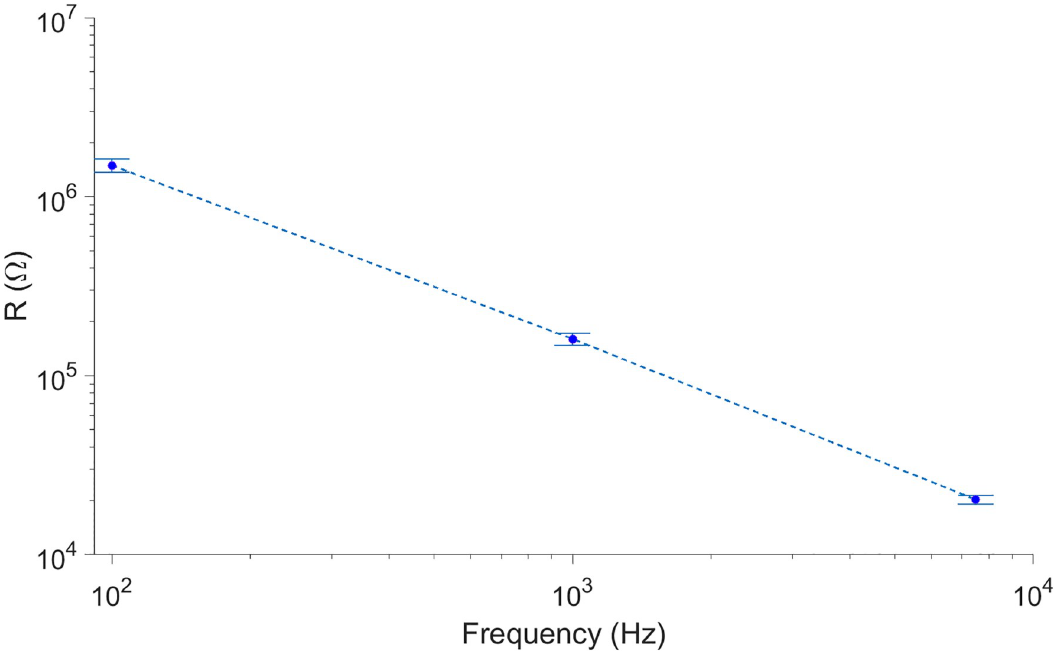
Fig 2. Impedance of gold electrodes from commercial MEA chips. The impedances were measured with the setup at fixed frequencies of 100, 1000 and 7500 Hz. The mean values of the impedance measured at each frequency are shown as blue dots connected by a discontinuous line. The values of the standard deviations are indicated by the error